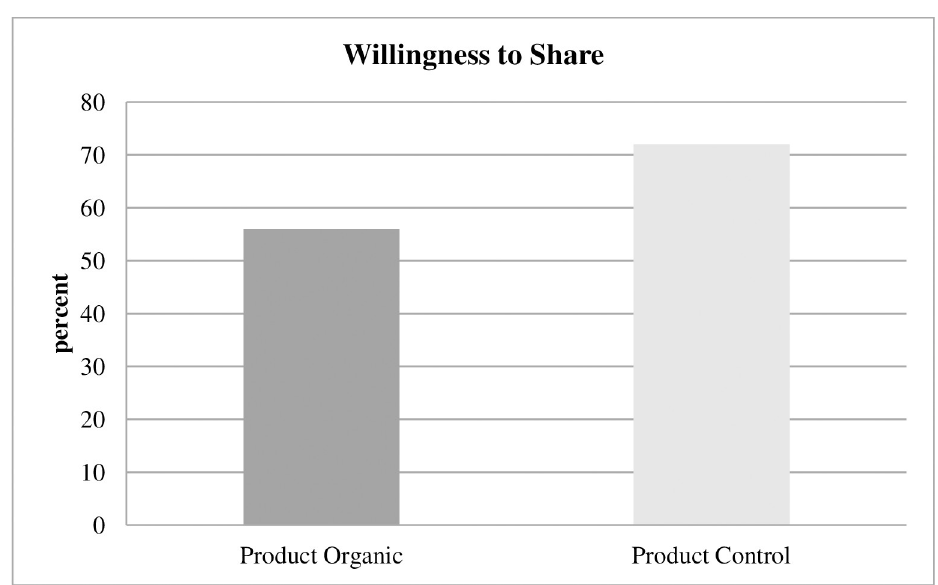
Fig 7. Willingness to share lottery treatments. Compared with the Product treatments, the share of donations is statistically comparable between subjects in the organic and the control treatment. The effects of dynamic moral self- licensing disappear in the Lottery